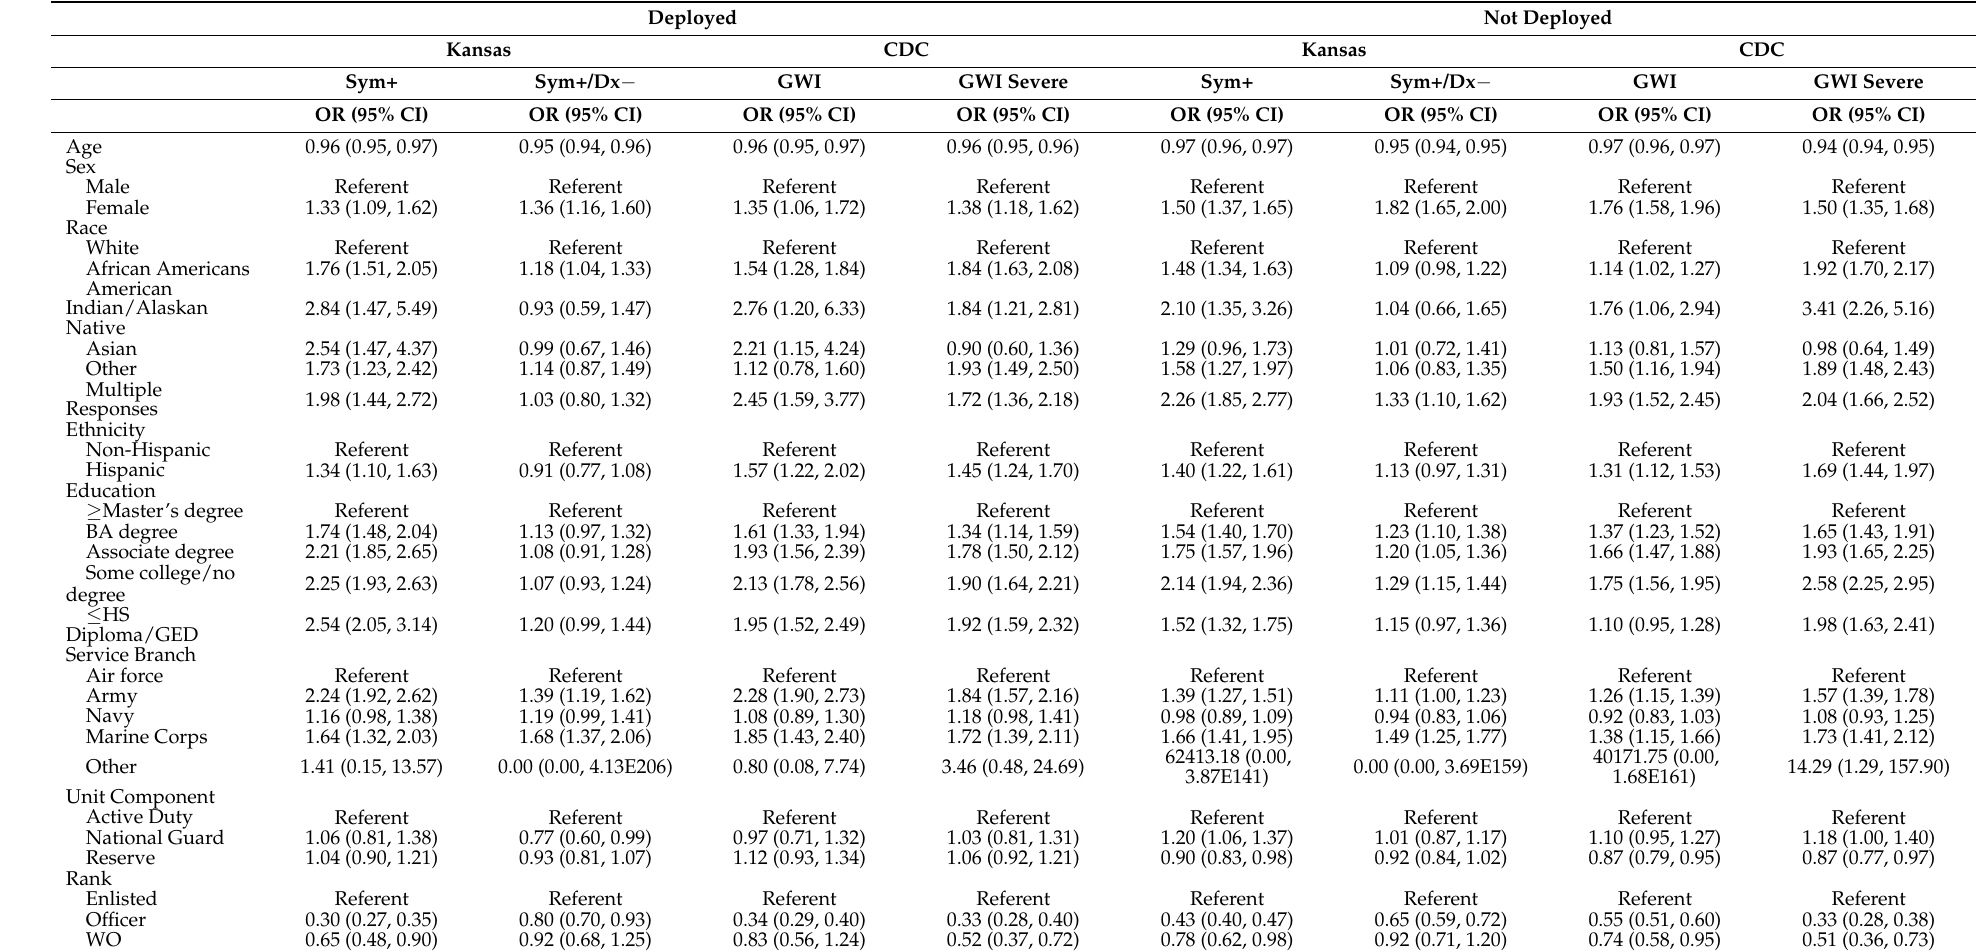
Table A8. Complete Case Analyses for Unadjusted Associations of Gulf War Illness Phenotypes with Demographic Characteristics. Deployed Not Deployed Kansas CDC